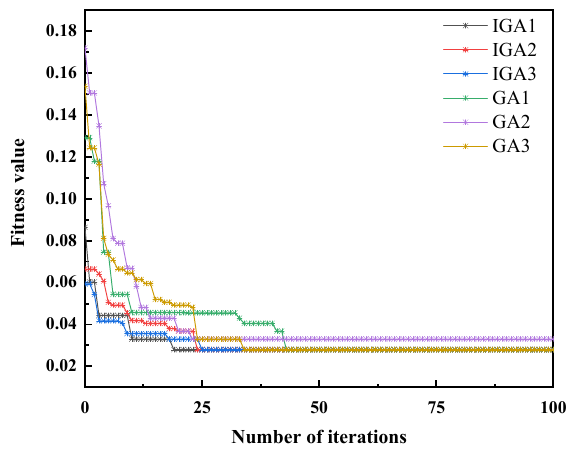
Figure 13. Comparison of the fitness values obtained by various GAs.